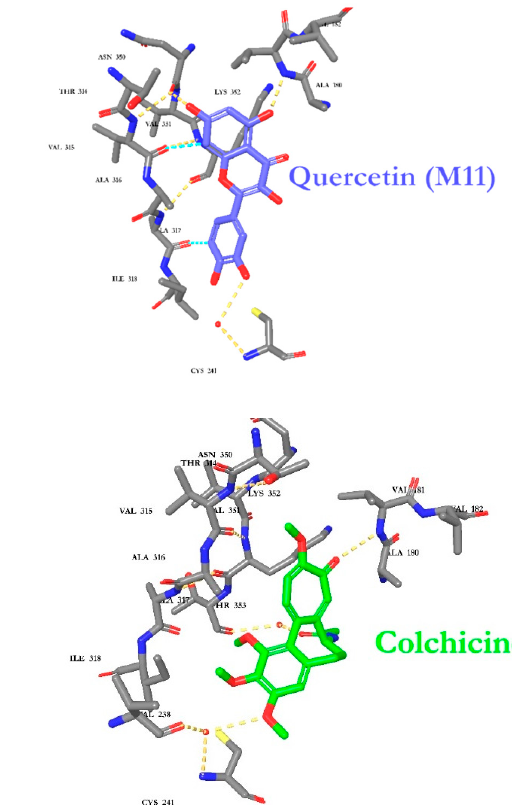
Figure 8. Docking poses for metabolite 11 ( M11 ) and Colchicine into Tubulin crystal structure.